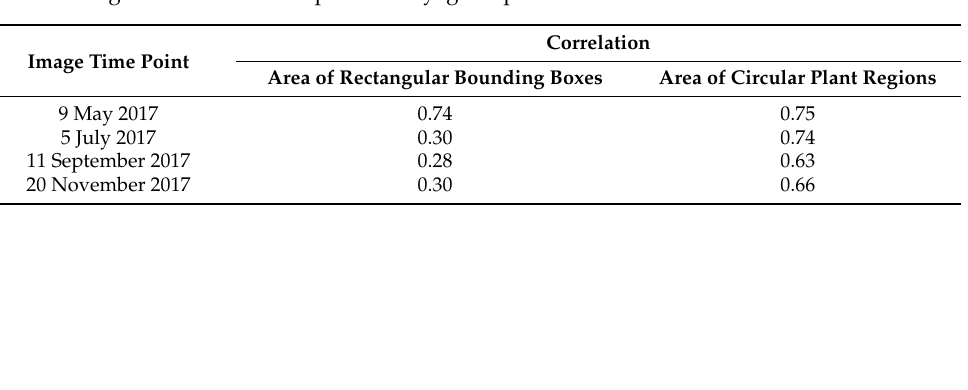
Table 1. Values of ˇr calculated for the area extracted from rectangular and circular plant regions with the fresh weights of subset of 480 perennial ryegrass